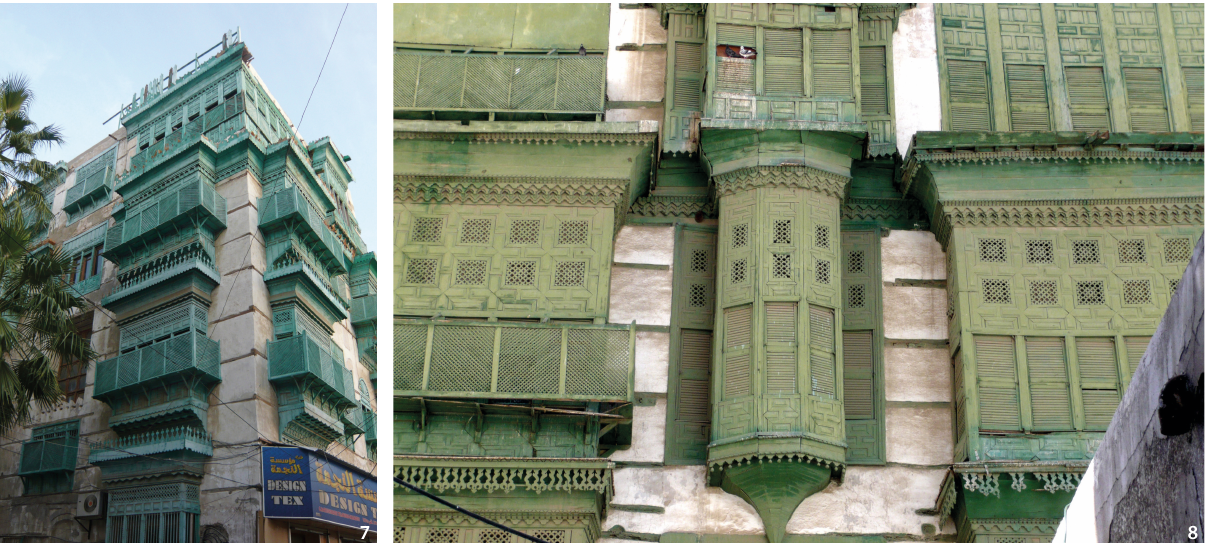
Figure 7 Shafey House, 2009 (Source: the author). Figure 8 Roshan of Noorwali House, 2009 (Source: the